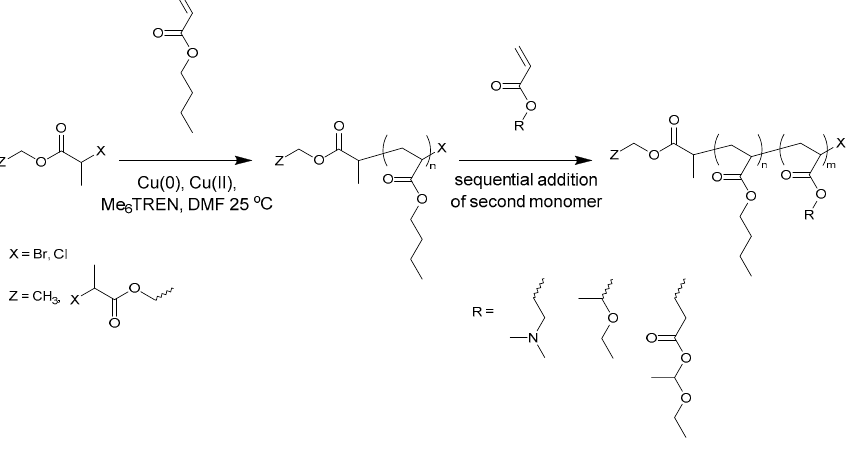
Figure 1. Synthesis of block copolymers by sequential monomer addition.